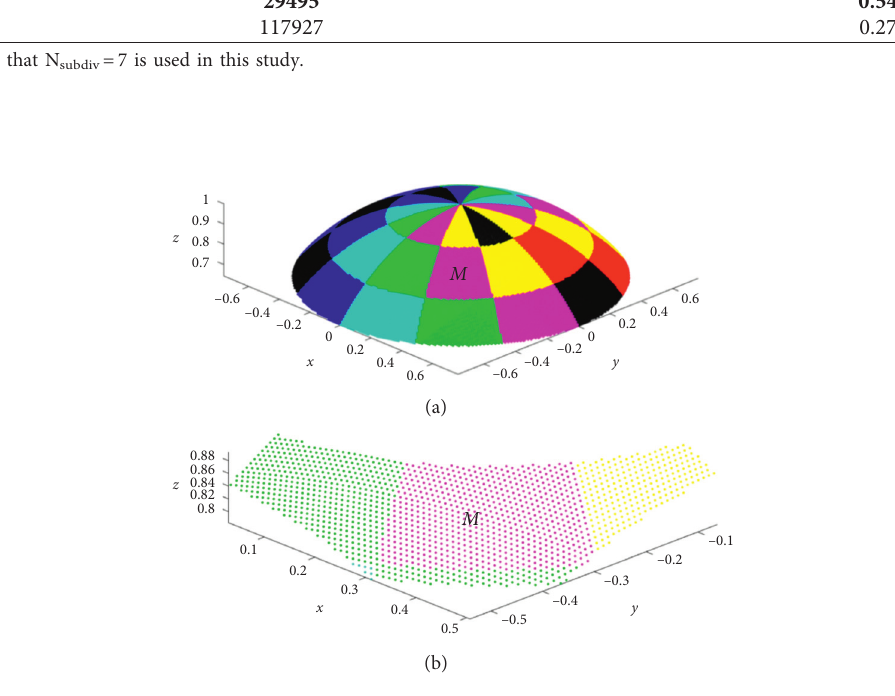
Figure 17: (a) The 2D-angle grid in the 7-element FOV ( N � 7 ) . The grid is subdivided into 36 angle zones that are defined by 12 equal subdiv divisions in Az-angle and 3 divisions in El-angle, i.e., [40 ° to 53 ° ], [53 ° to 70 ° ], and [70 ° to 90 ° ]. (b) A zoom-in plot of zone M in